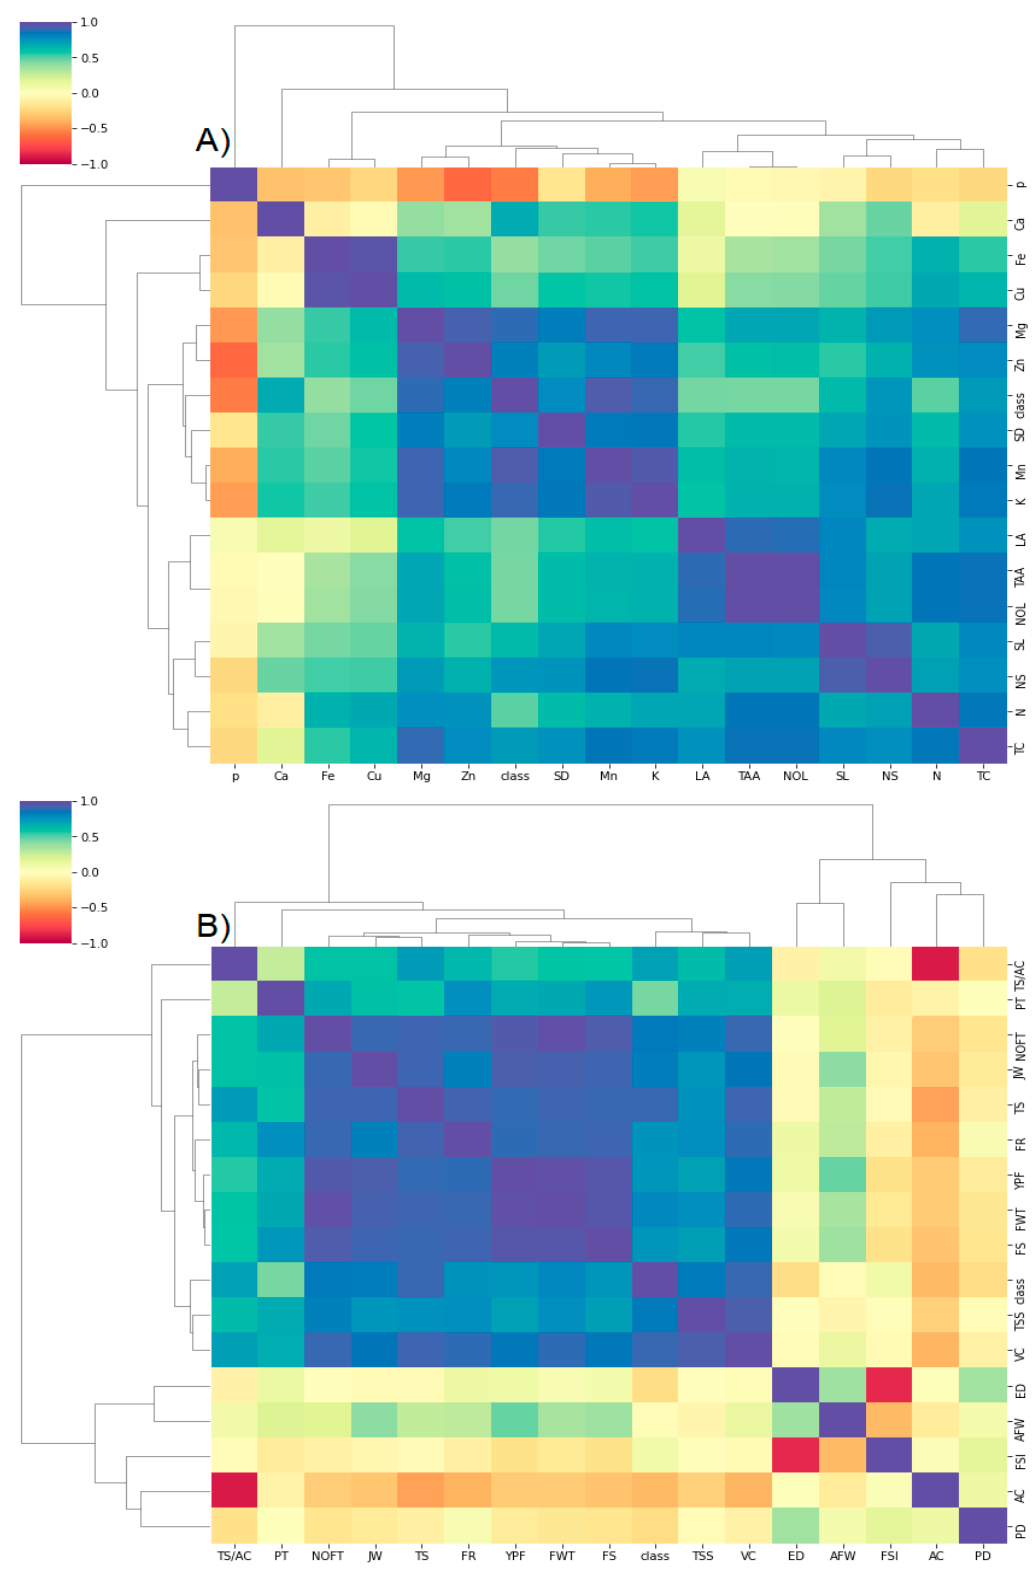
Figure 2. Heatmap correlation matrix for the vegetative growth, chlorophyll, and mineral contents ( A ), as well as the fruit aspects and quality ( B ).